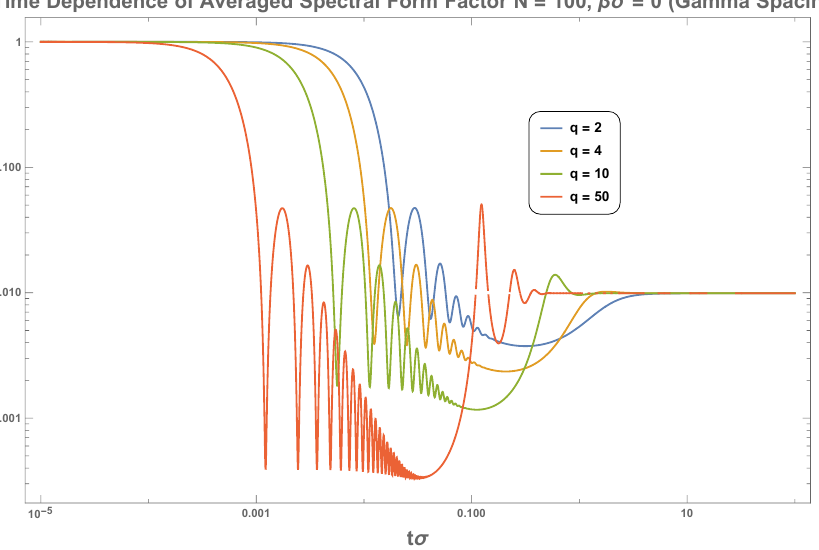
Figure 9 . Above is a Log-Log plot of the averaged spectral form factor at, infinite temperature, for a spectrum generated by the i.i.d model with a NNS distribution given by the gamma distribution defined in eq. (3.15). The value of N is fixed and the form factor is plotted for different values of q . The energy scale, σ , is related to the average energy spacing between nearest neighbor eigenvalues, h δE i , through the following relation h δE i = ( q + 1) σ .